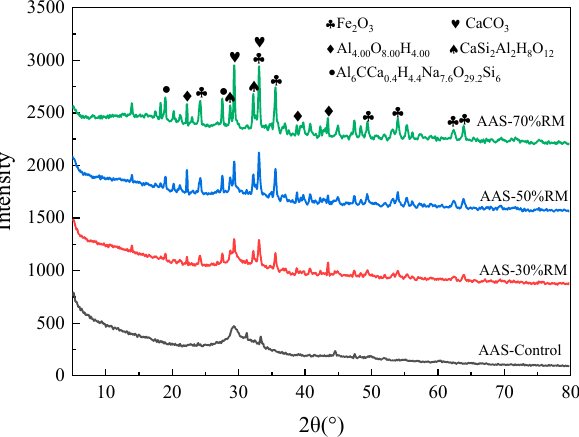
Figure 7. The XRD patterns of the alkali slag-red with different additions of RM.